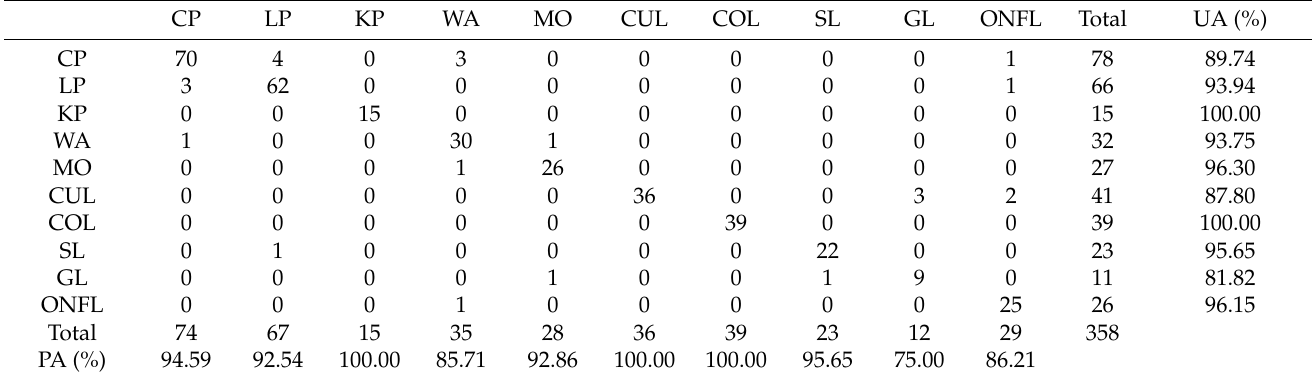
Table 3. Confusion matrix of classification result of